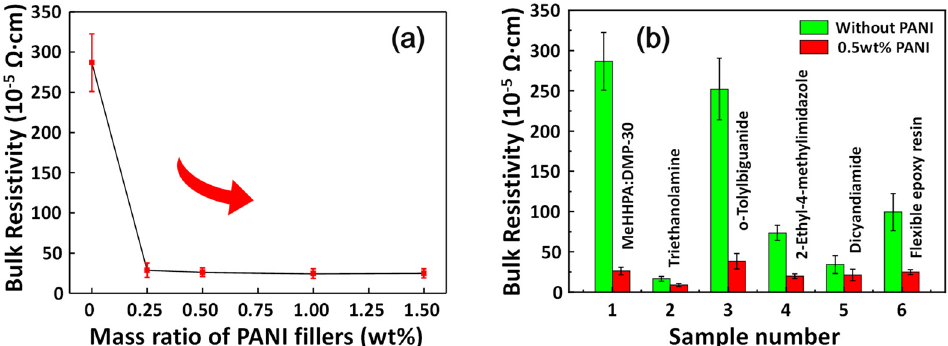
Figure 3. ( a ) The change trend of ECAs with adding different amount of PANIs; ( b ) Comparison of PANIs’ improvement effect on ECAs cured with different curing agents. Table 1. Comparison of PANIs’ improvement effect on ECAs cured with different curing agents. No.